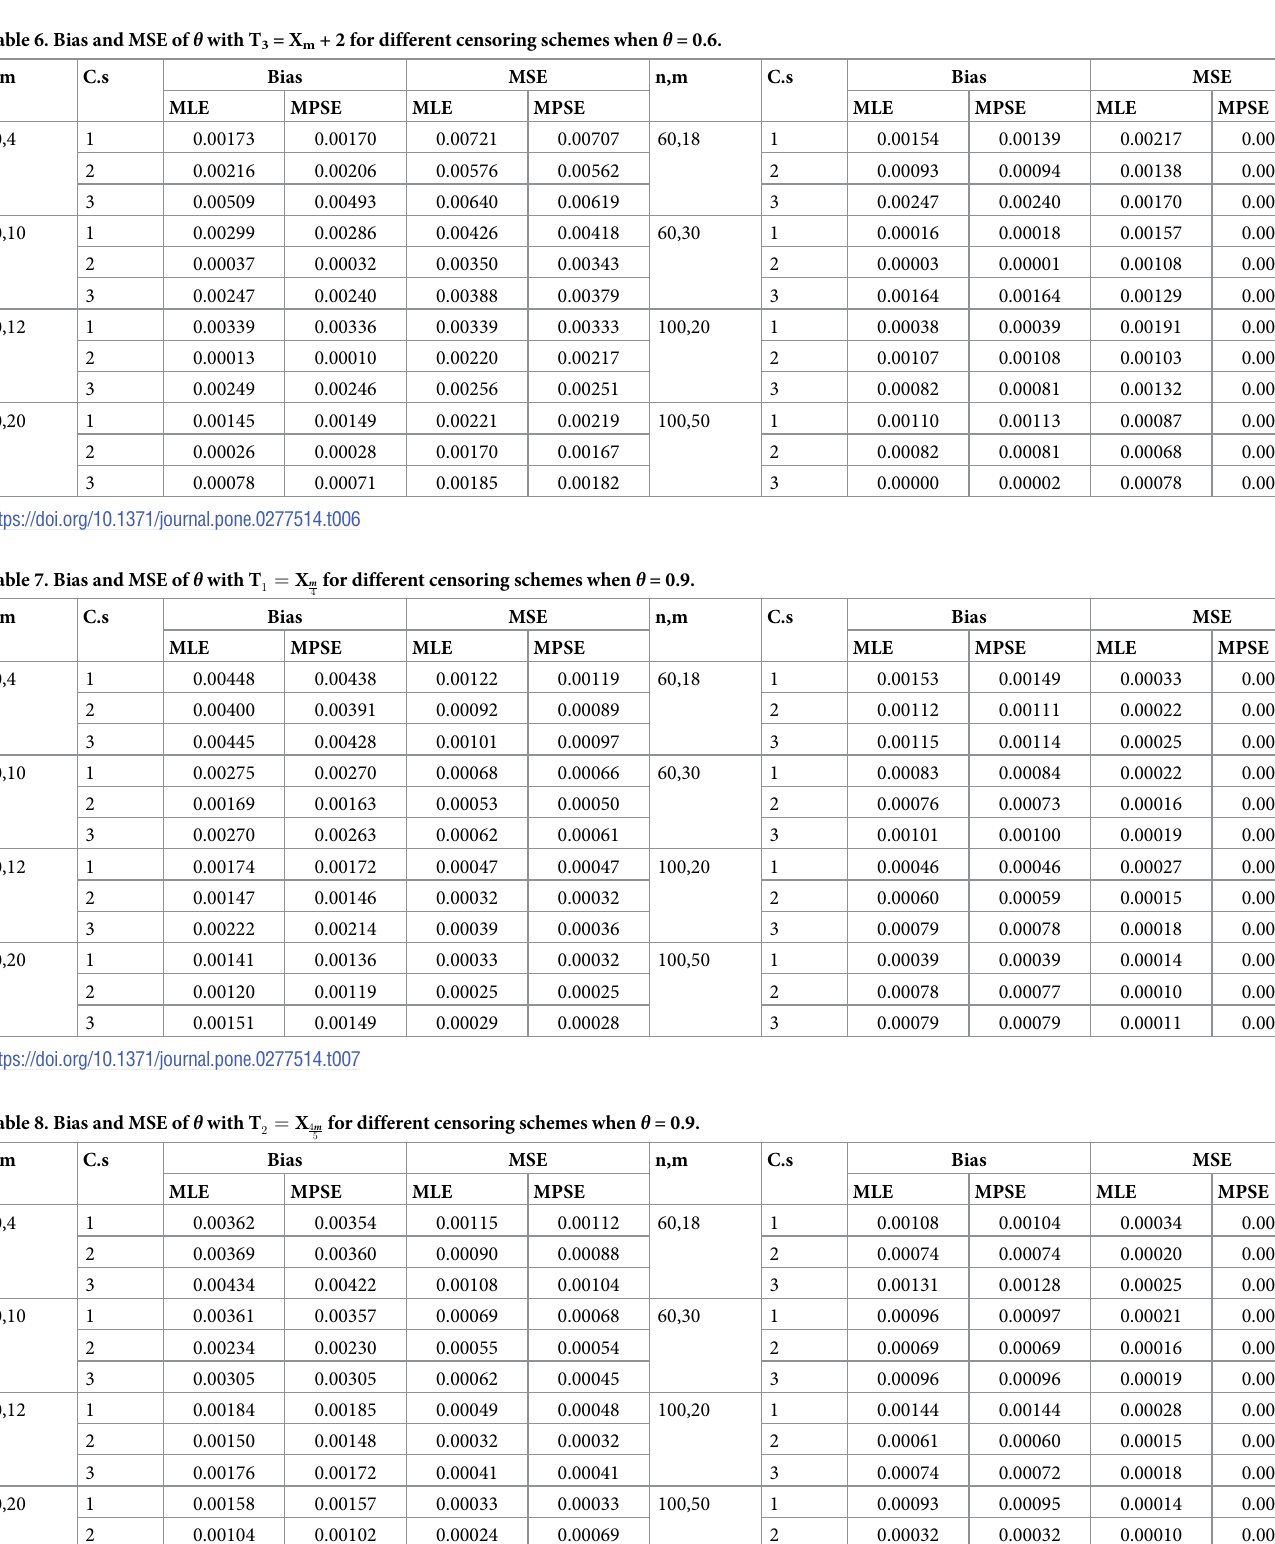
Table 6. Bias and MSE of θ with T 3 = X m + 2 for different censoring schemes when θ = 0.6.